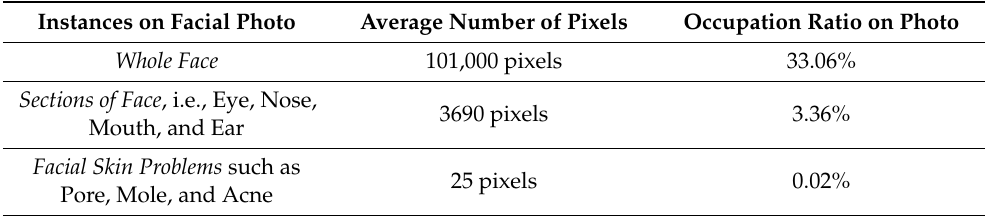
Table 2. Comparing occupation ratios of face, face section, and facial skin problem areas. Instances on Facial Photo